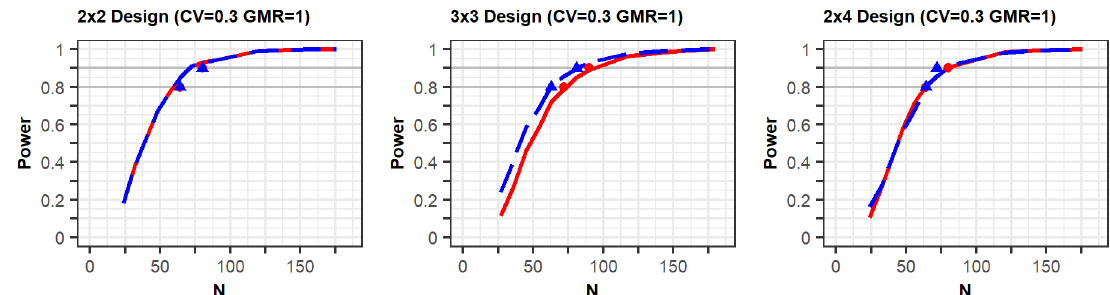
Figure 1. Comparison between results of the proposed method and a previous study: The power curves as per the EMA and FDA guidelines are represented as the red solid lines and blue dashed lines, respectively. The red circle points (EMA) and blue triangle points (FDA) indicate the total number of observations (N) of 80% and 90% power in the previous study [10], respectively.